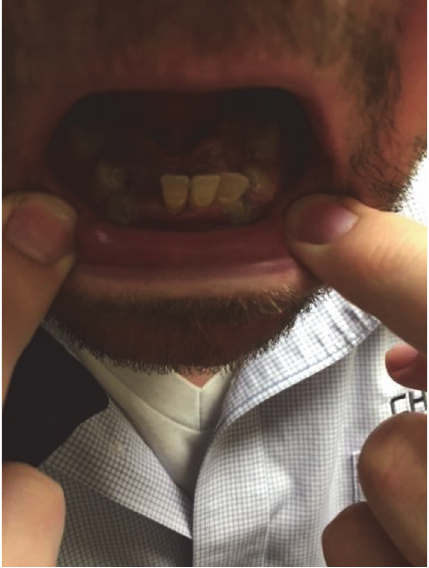
Figure 3: Dysplastic permanent teeth.